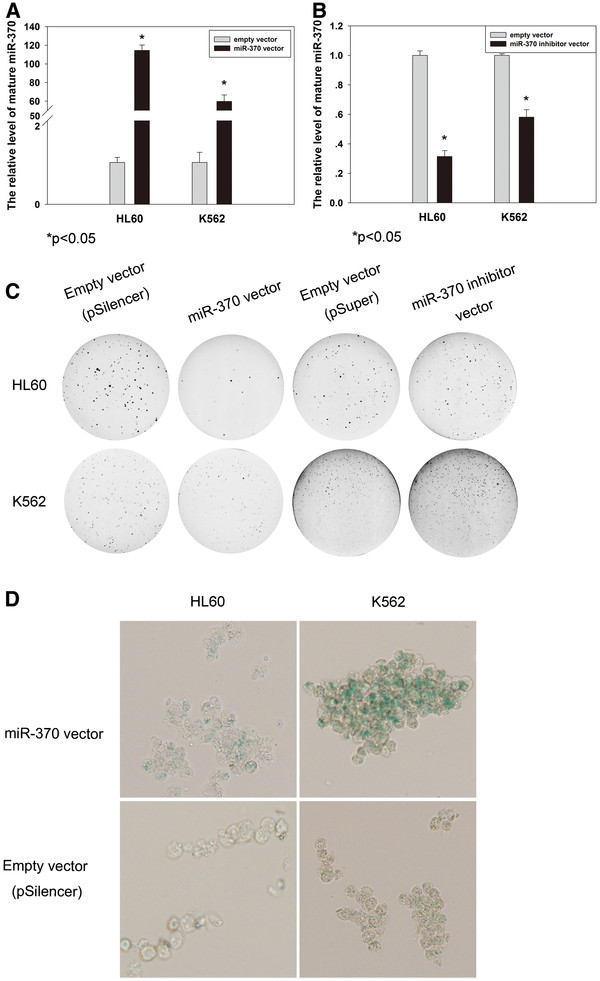
Suppression of AML cell proliferation and induction of cell senescence by overexpression of miR-370 in vitro while anti-miR-370 expression increases cellular ability of proliferation. (A) miR-370 expression in AML cell lines and its overexpression using a specific miR-expressing pSilencer vector. The cells were transfected with either miR-370 precursors or with control precursor and harvested after 48 hours. qRT-PCR was applied to detect mature miR-370 level. (B) The depletion of miR-370 expression by a specific miR-370-inhibiting pSuper plasmid. The method was similar as above. (C) Alterations in foci formation after different treatments in AML cells. The cells were first treated as above and the efficiently changed miR-370 expression was verified in (A) and (B). For clonogenic assays, 5,000 cells/well (in 6-well plates) were incubated for 14 days and the foci number was counted. (D) Senescence onset of miR-370-overexpressed AML cells. β-Gal staining was performed and % of positive cells was calculated